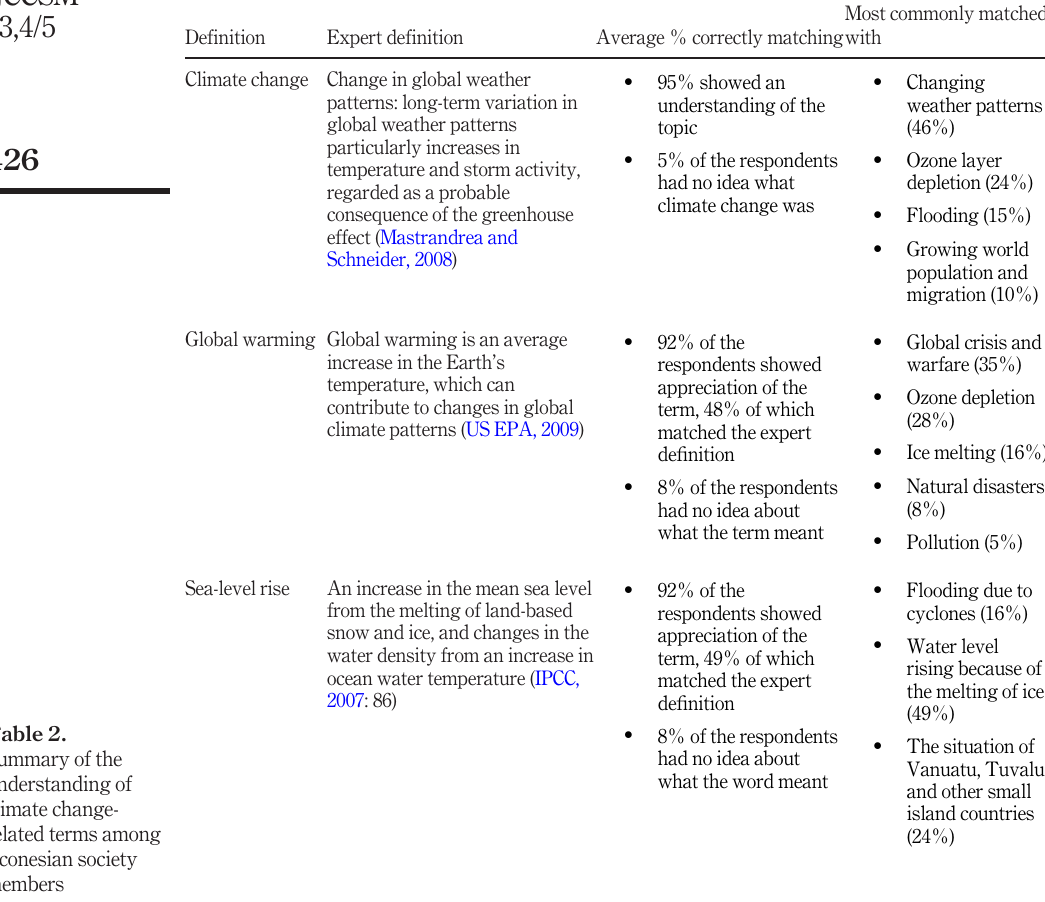
Table 2. Summary of the understanding of climate